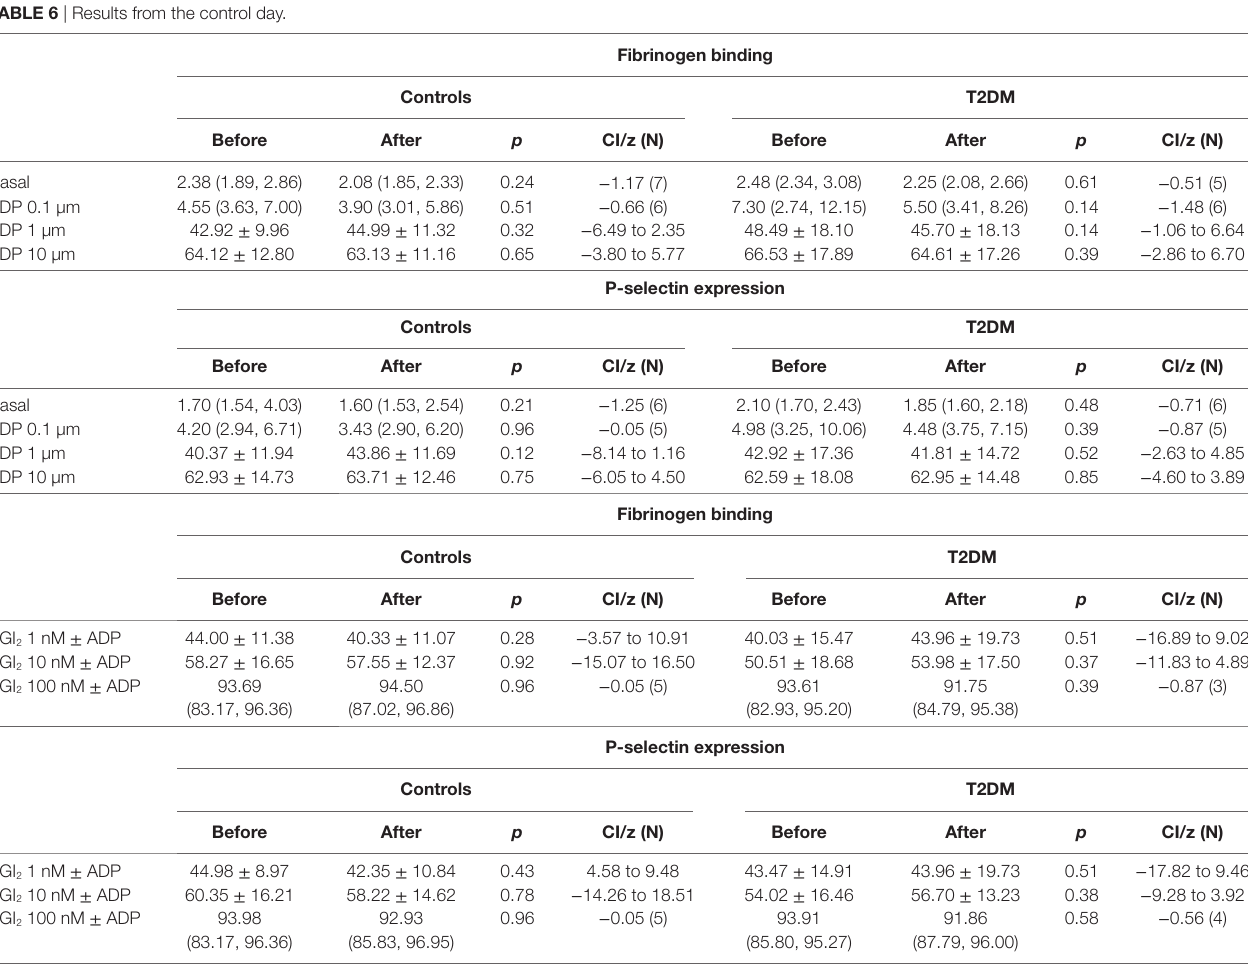
Table 6 | Results from the control day.